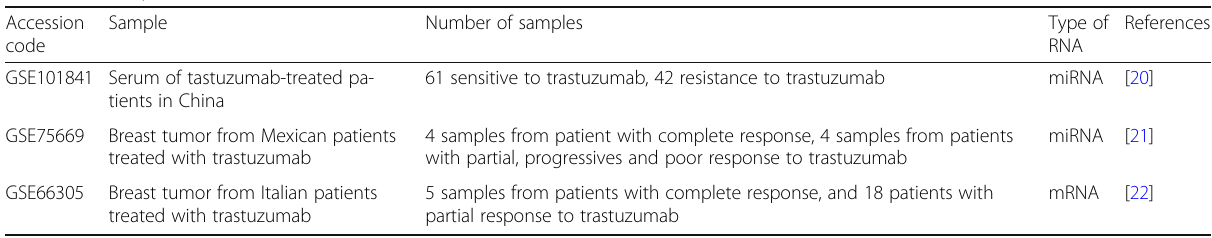
Table 1 Description of GSE